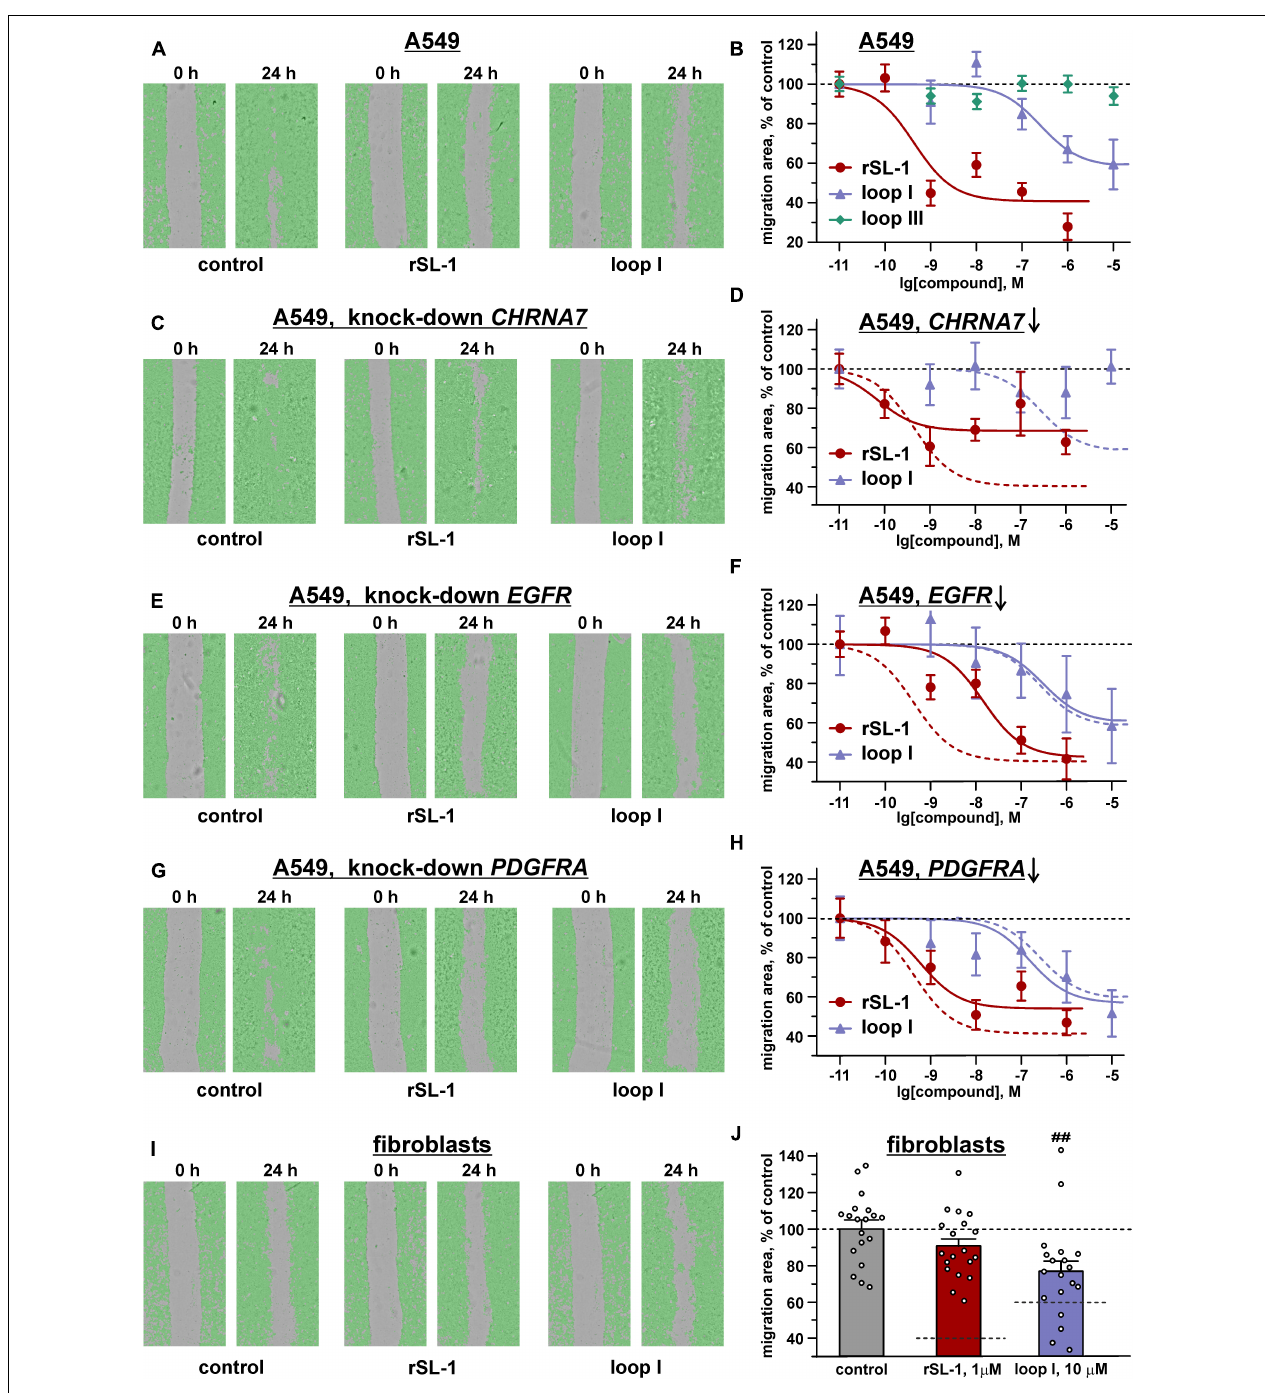
FIGURE 3 | Influence of rSLURP-1 and the “loop I” and “loop III” peptides on migration of A549 cells (A–H) and primary mouse lung fibroblasts (I,J) . The data obtained for knockdown of the CHRNA7 , EGFR , and PDGFRA genes are shown on the panels (C,D) , (E,F) , and (G,H) , respectively. (A,C,E,G,I) Representative pictures of scratch assay, obtained on CloneSelect Imager after 24 h incubation of the cells with 1 µ M of rSLURP-1 or 10 µ M of the “loop I” peptide. (B,D,F,H,J) Effect of different rSLURP-1 and the “loop I” and “loop III” peptides concentrations on the migration of the cells. Data are presented as a mean scratch surface, occupied by migrating cells (% normalized to control), ± SEM, n = 7–21; The parameters describing the dose-response curves (EC 50 , A 1 ) and results of statistical comparisons are given in Table 1 . Control level (100%) and position of the migration inhibition curves for rSLURP-1 and the “loop I” peptide in A549 cells without knock-down are shown by dashed lines. (J) Control level (100%) and the migration inhibition effects for 1 µ M of rSLURP-1 and 10 µ M of the “loop I” peptide in A549 cells are shown by dashed lines. ## ( p < 0.01) indicates significant difference from control group by one-way ANOVA/Dunnett’s test.